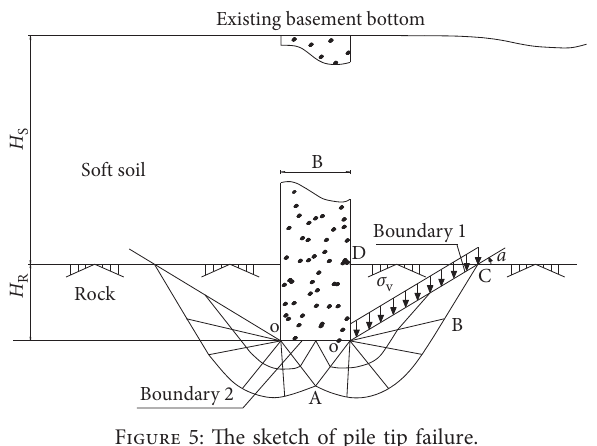
Figure 5: The sketch of pile tip